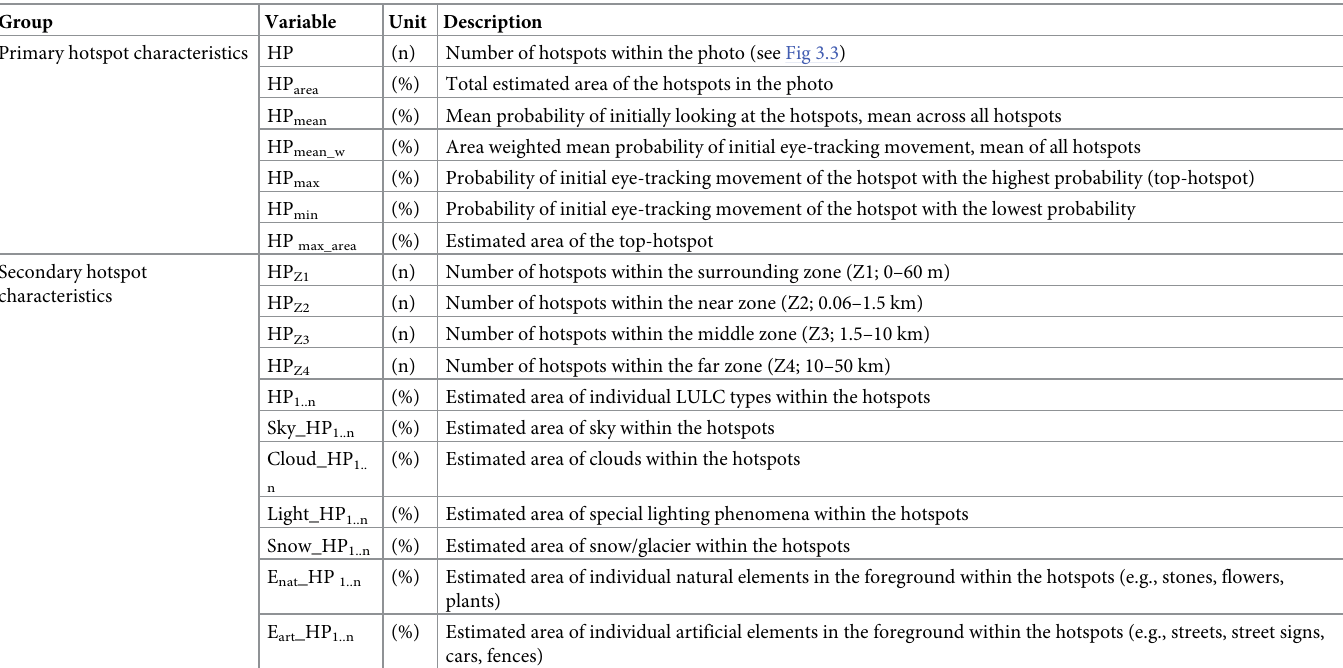
Table 1. Variables extracted from the hotspots that were identified by 3M-VAS.